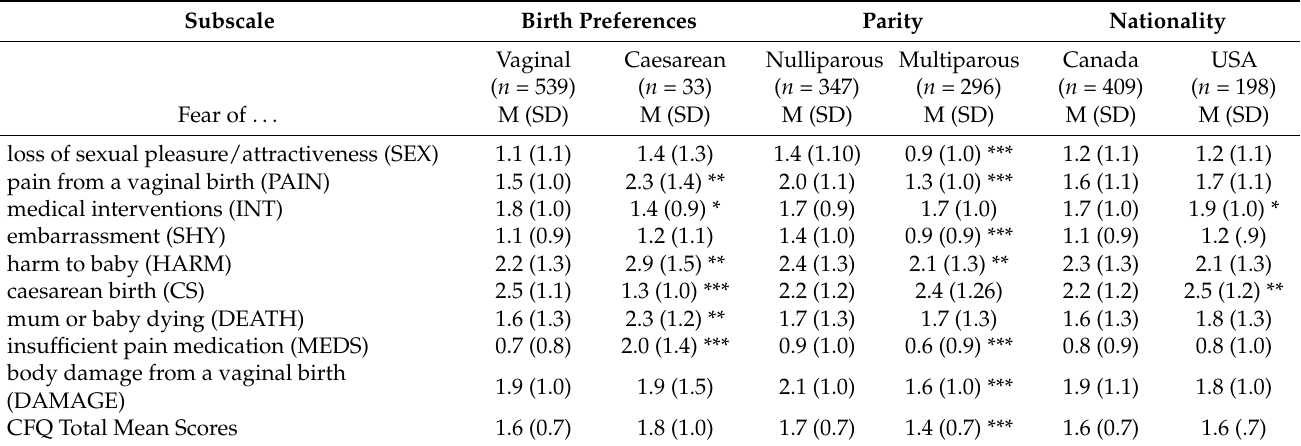
Table 7. CFQ subscale means (M) and standard deviations (SD): by delivery preference and